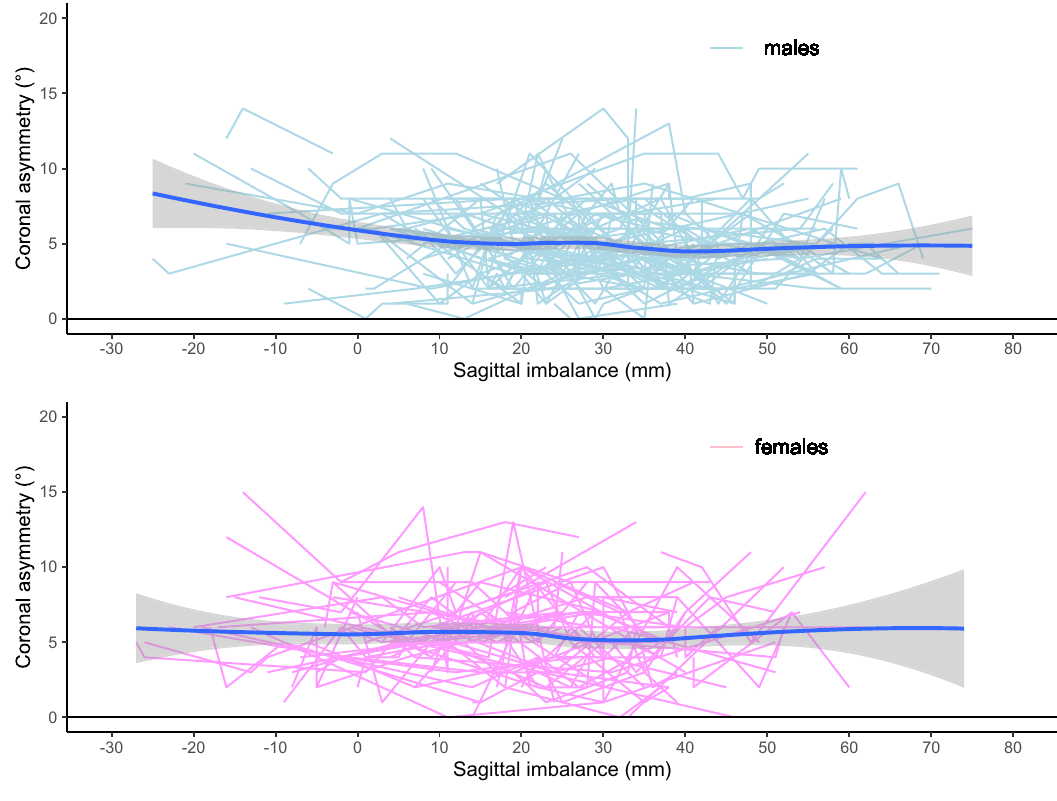
Figure 3. Spaghetti plot of sagittal imbalance (mm) against coronal asymmetry